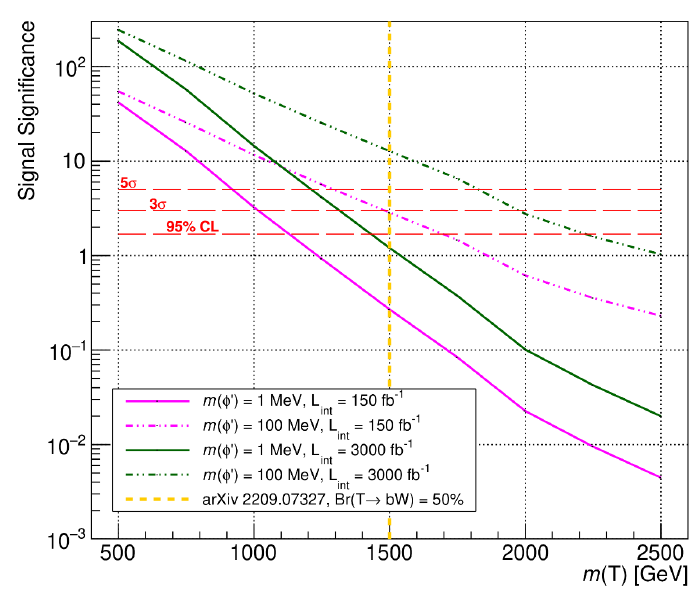
Figure 10 . Signal significance as a function of m ( T ) , for scenarios with m ( φ 0 ) = 1 MeV (magenta) and m ( φ 0 ) = 100 MeV (green) and for scenarios with L int = 150 fb − 1 (solid lines) and L int = 3000 fb − 1 (dashed lines). The dashed vertical yellow line indicates the lower limit on m ( T ) found in [39], assuming Br( T → bW ) = 50% . Figure 11 . Signal significance as a function of m ( T ) and Br( T → Wb ), for m ( φ 0 ) = 100 MeV. The heat map levels correspond to signal significance, while overlaid dashed lines correspond to the 95% confidence level (yellow), 3 σ discovery potential (green), and 5 σ discovery potential (red), assuming L int = 3000 fb − 1